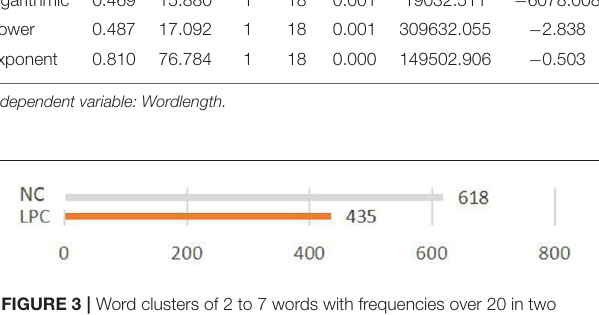
FIGURE 3 | Word clusters of 2 to 7 words with frequencies over 20 in two